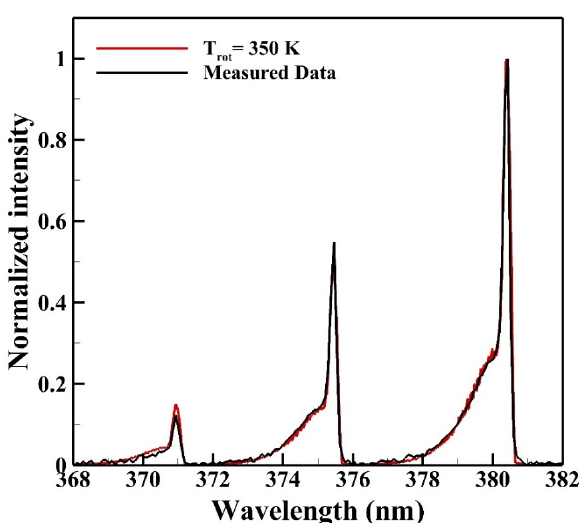
Figure 7. The rotational temperature of the reactive zone is determined as 350 K from the emission spectrum of the N 2 second positive system (SPS).